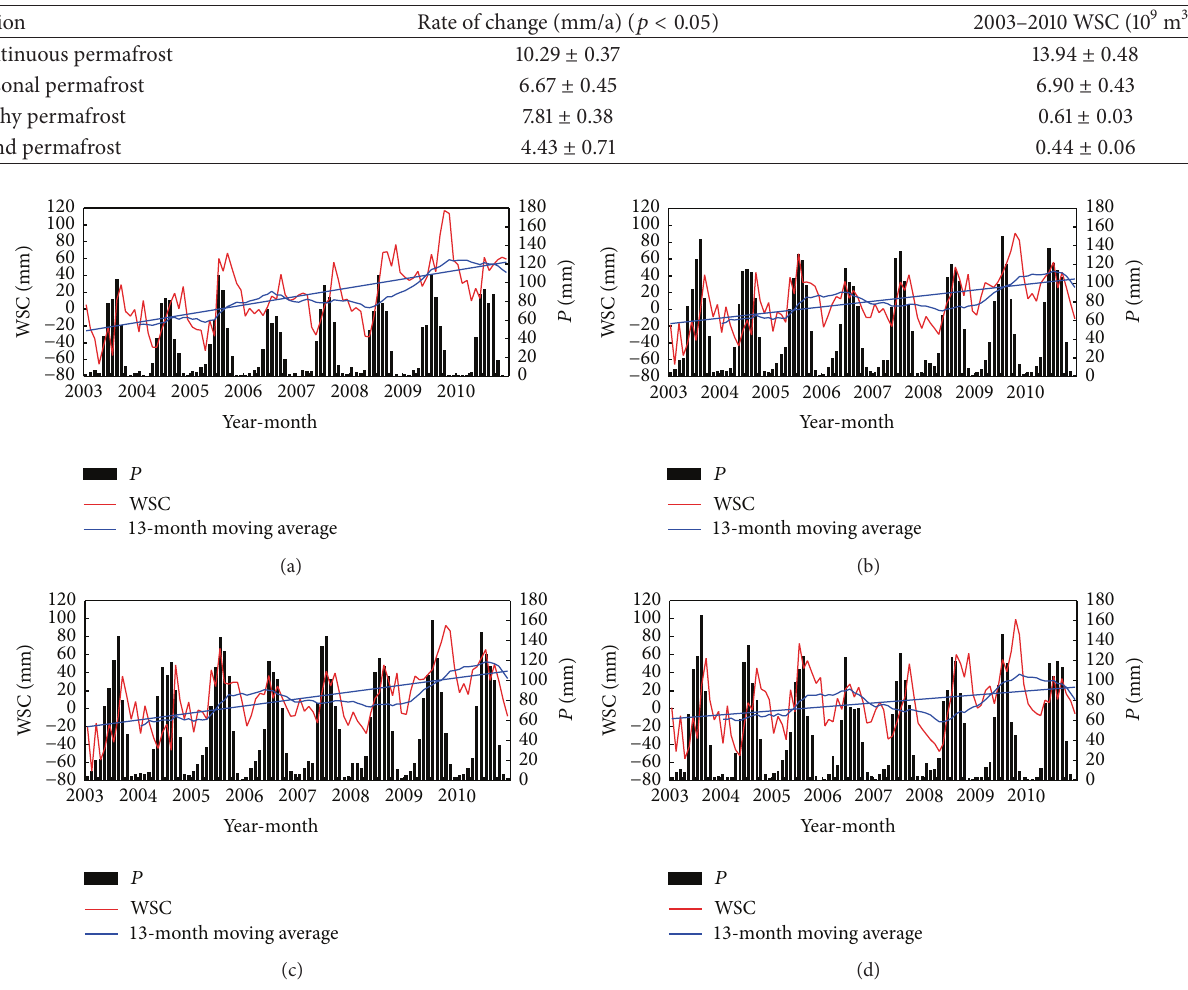
Table 2: Amount of water storage change (WSC) over different types of permafrost in the Three-River Source Region during 2003–2010. Region